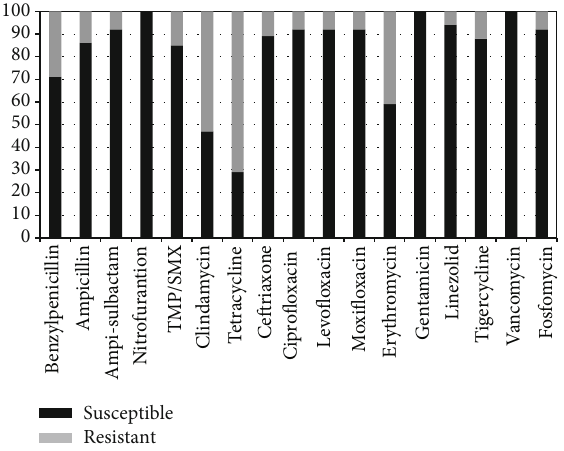
Figure 4: Percentage of Gram-positive bacteria isolates susceptible to antimicrobial drug. TMP/SMX: trimethoprim/sulfamethoxazole.